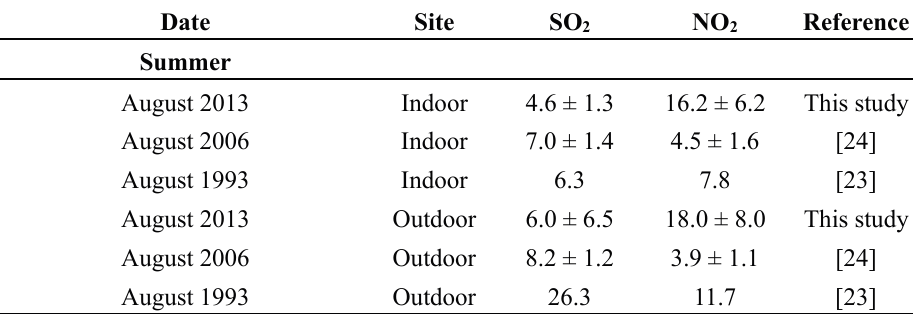
Table 5. The concentrations of acidic gaseous pollutants inside and outside the Pit No.